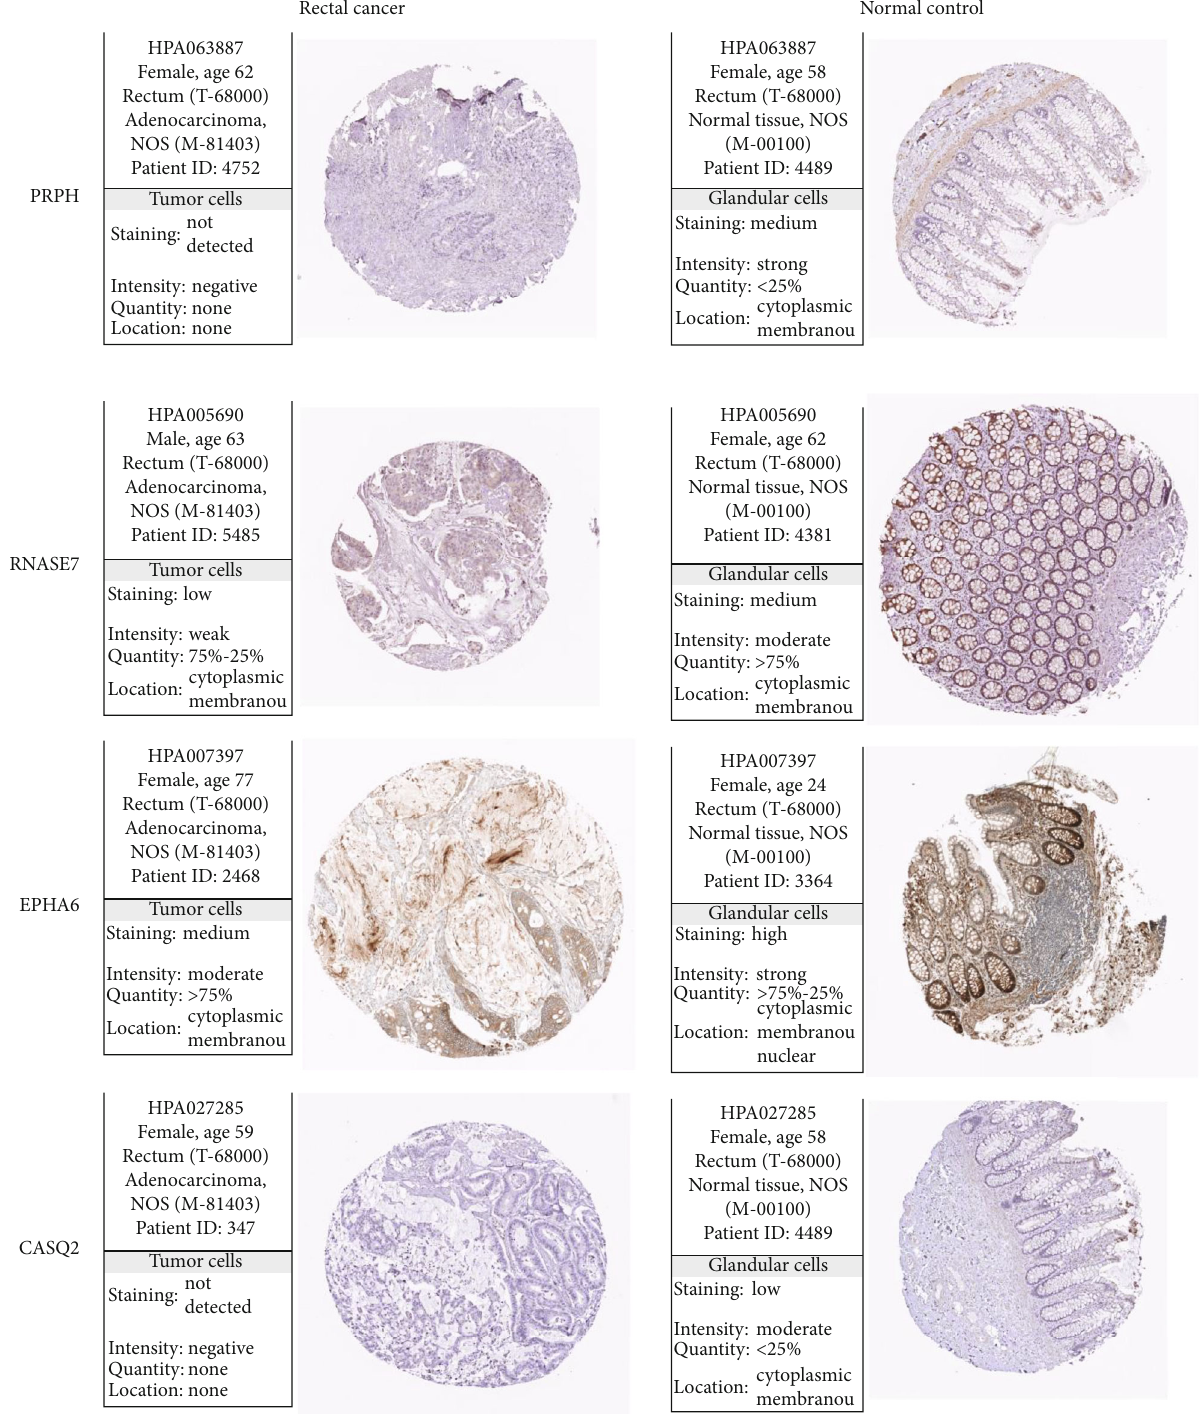
Figure 8: Protein expression of prognostic genes and their interaction genes validated using the online HPA